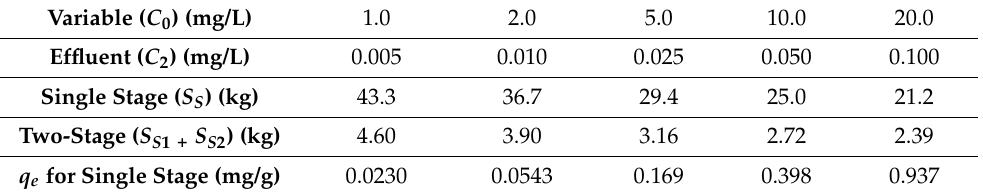
Table 7. Minimum total amount of acid-activated date stone carbon for 99.5% removal of ibuprofen in single ( S S ) and two-stage ( S S 1 + S S 2 ) operations for C 0 values and 1000 L of solution.